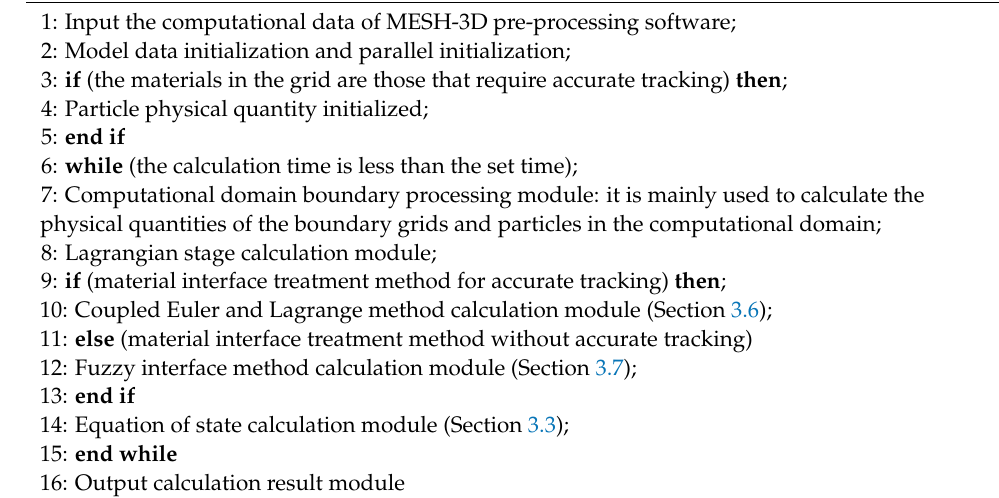
Algorithm 1 Flow Chat of the Calculation Module